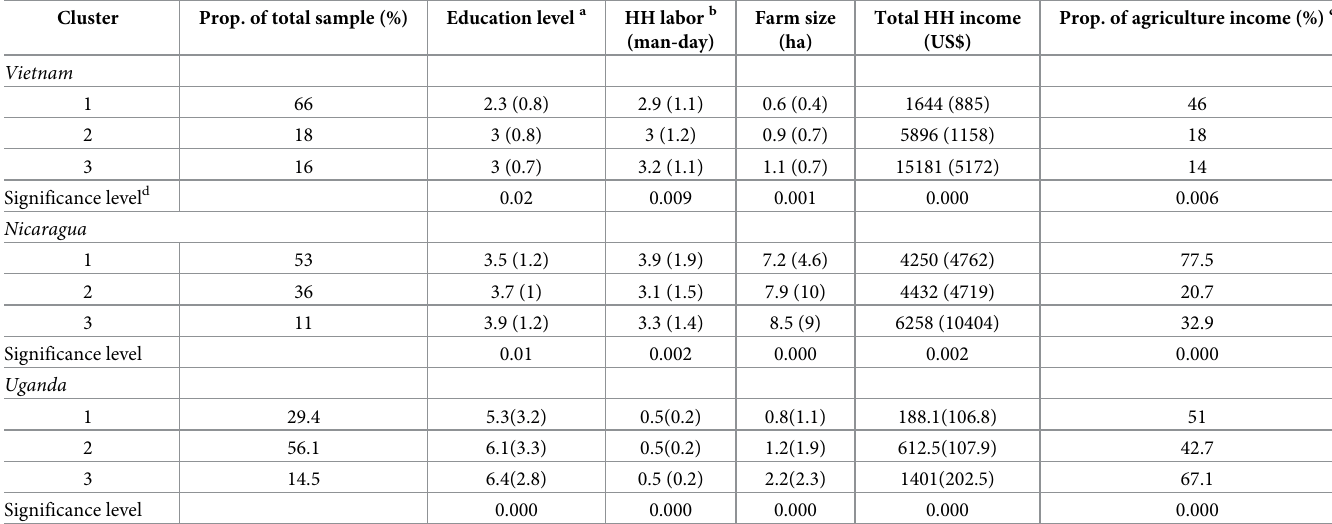
Table 5. Descriptive information of clusters in the three case studies. Cluster Prop. of total sample